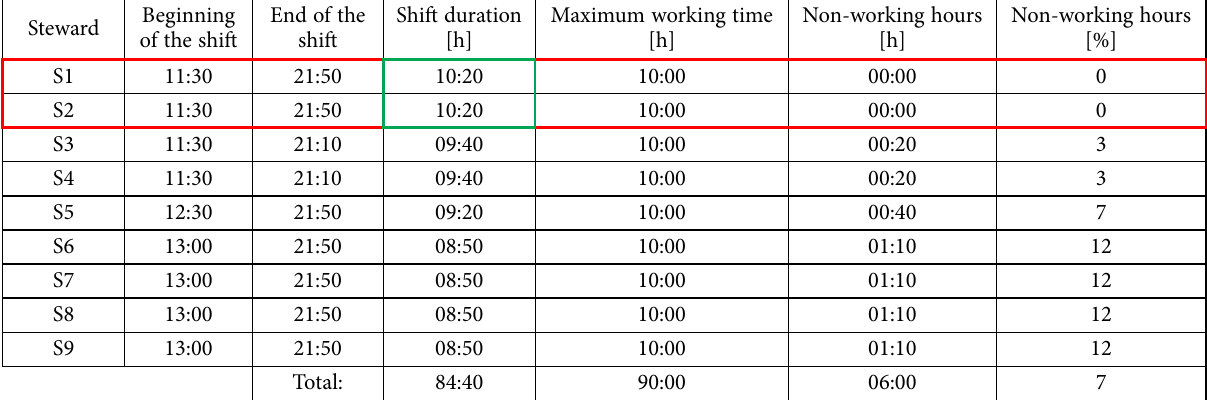
Table 8. Numerical results for instance of 5 flights